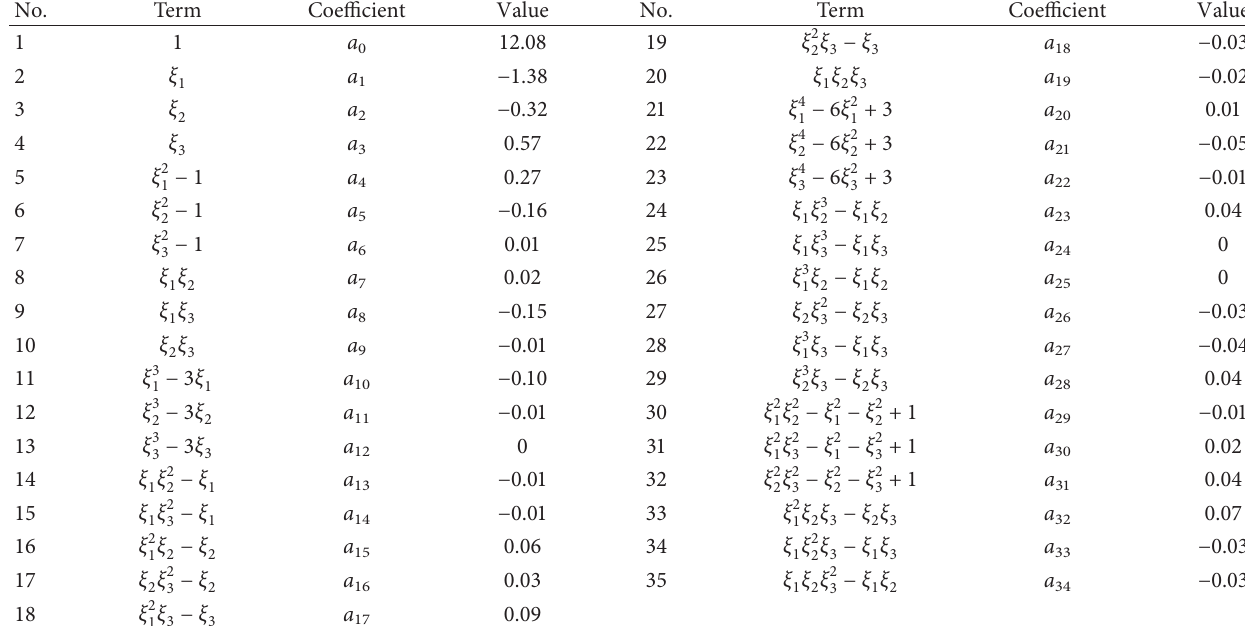
Table 4: Expansion terms and coefficients of the 4 th order HPCE for the 1 st excavation